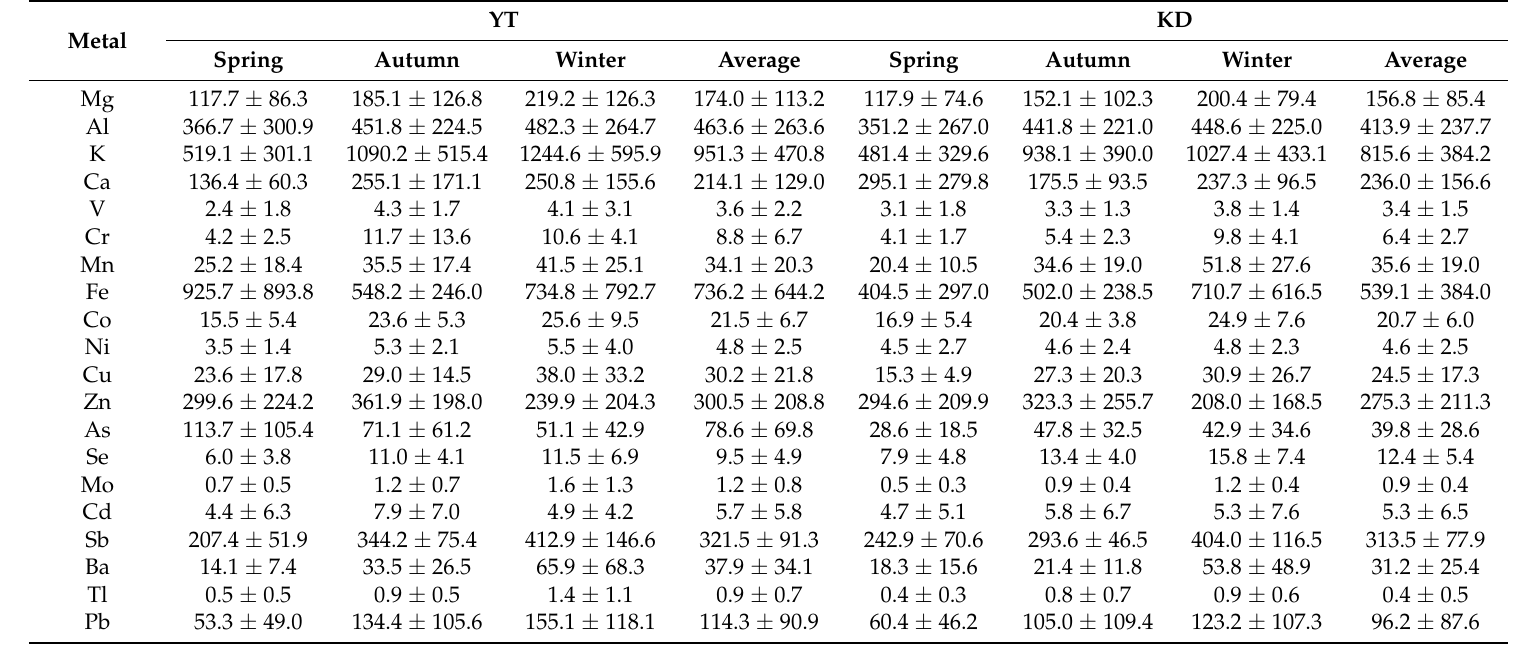
Table 4. Concentrations (ng/m 3 ) of metal elements in PM 2.5 during the sampling periods at the YT and KD